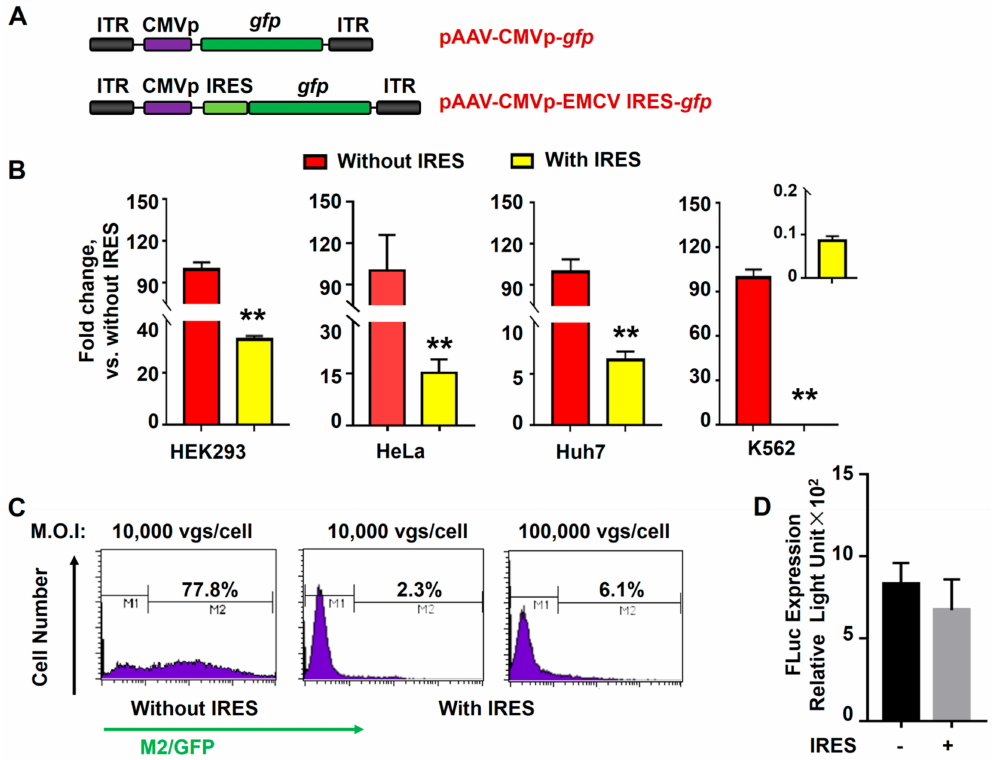
Figure 2. In-cis encephalomyocarditis virus (EMCV) internal ribosome entry site (IRES) inhibited the expression of transgene in K562 cells. ( A ) Diagram of the rAAV6 vector genomes. ( B ) HEK293, HeLa, Huh7, and K562 cells were transduced with rAAV6-CMVp- gfp or rAAV6-CMVp-EMCV IRES- gfp at 10,000 vgs / cell. Transgene expression was detected by fluorescence microscopy at 72 hours post-transduction. ( C ) Flow cytometry analysis of GFP-positive cell number in K562 cells transduced with rAAV6 vectors at the indicated MOI. Transgene expression was detected by flow cytometry at 72 hours post-transduction. ( D ) K562 cells were transduced with rAAV6-CMVp- fluc at 10,000 vgs / cell and coinfected with either rAAV6-CMVp- gfp or rAAV6-CMVp-EMCV IRES- gfp at 10,000 vgs / cell. The expression of firefly luciferase was measured at 72 hours